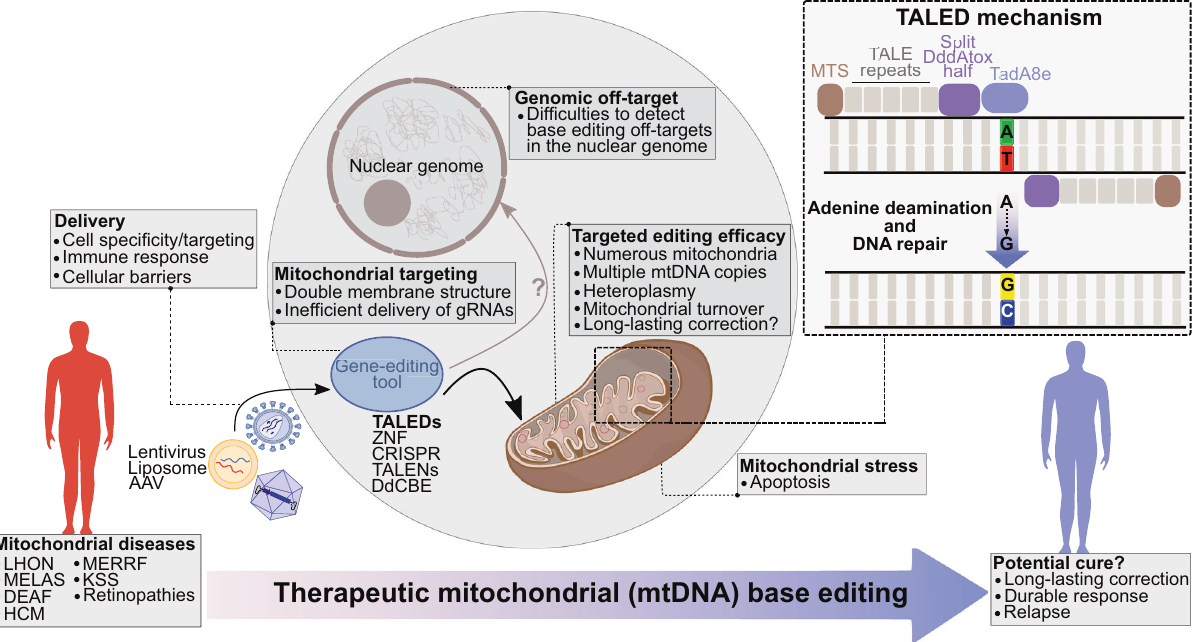
Fig. 1 Challenges and promises of mitochondrial DNA (mtDNA) base editing applications to treat mitochondrial diseases. Ef fi ciency of mtDNA base editing is dependent upon several factors, including ef fi cient delivery to diseased cells, targeting of the mitochondria and mtDNA within these cells, as well as lack of off-target base editing activities. Abbreviations: LHON Leber hereditary optic neuropathy; MELAS mitochondrial encephalopathy, lactic acidosis and stroke-like episodes; DEAF deafness, sensorineural hearing loss; HCM hypertrophic cardiomyopathy; MERFF myoclonus epilepsy associated with ragged red fi bers; KSS Kearns-Sayre syndrome; AAV adeno-associated virus; TALENs transcription activator-like effector nucleases; ZFN zinc- fi nger nucleases; CRISPR clustered regularly interspaced short palindromic repeats; TALEDs transcription activator-like effector deaminases; DdCBE DddA-derived cytosine base editor; MTS mitochondrial targeting sequence; DddAtox double-stranded DNA deaminase toxin A; TadA8e deoxyadenosine deaminase